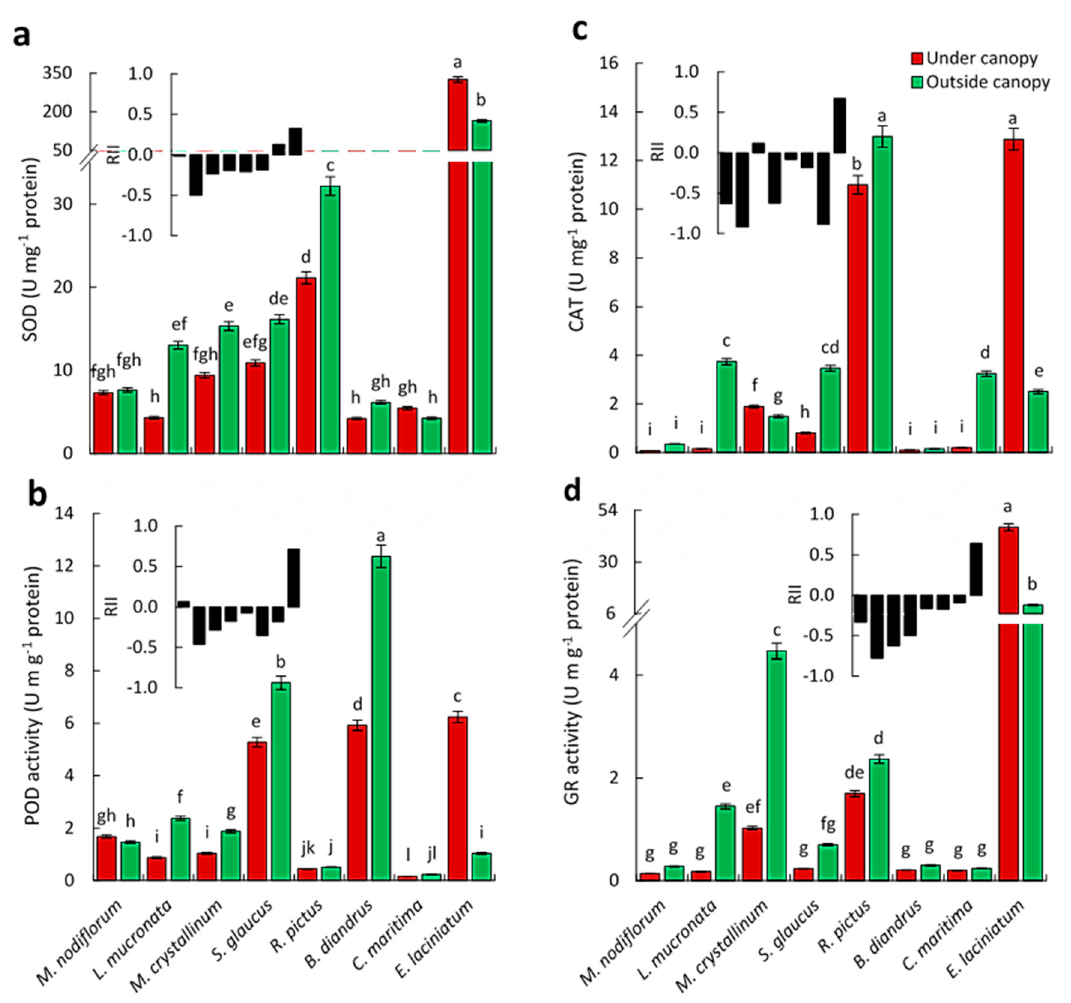
Figure 5. Antioxidant enzymes activity of the eight selected associated species in response to C. polygonoides shrubs (under and outside canopy) as well as the relative interaction index (RII) as black columns. ( a ) Superoxide dismutase (SOD) activity. ( b ) Peroxidase (POD) activity. ( c ) Catalase (CAT). ( d ) Glutathione reductases (GR) activity. Columns with the same letter are not significantly different after Duncan’s post-hoc test ( p ≤ 0.05). Values are average ± standard error ( n = 5).